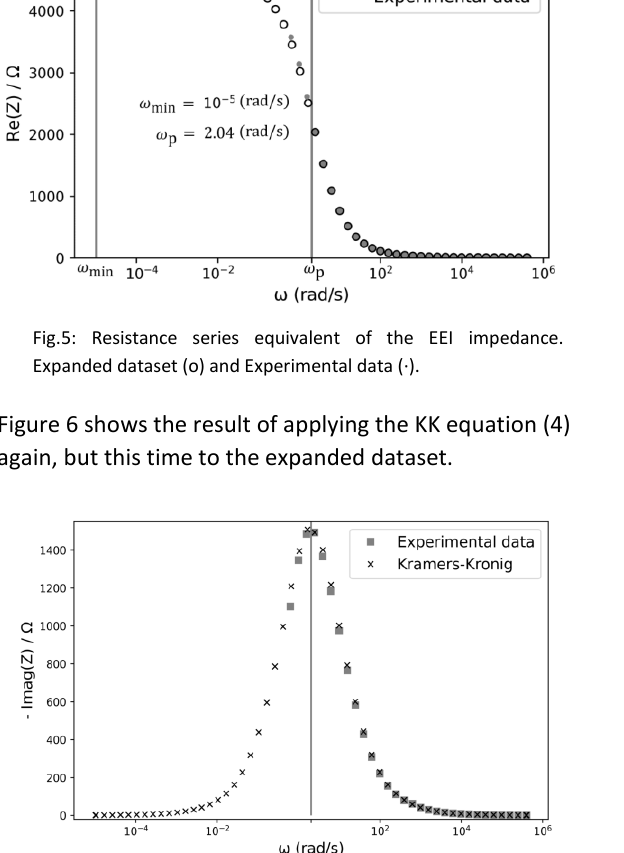
Fig.6: Reactance series equivalents of the EEI versus frequency. Experimental data (  ) and applying the KK equation (4) to the expanded dataset ( x